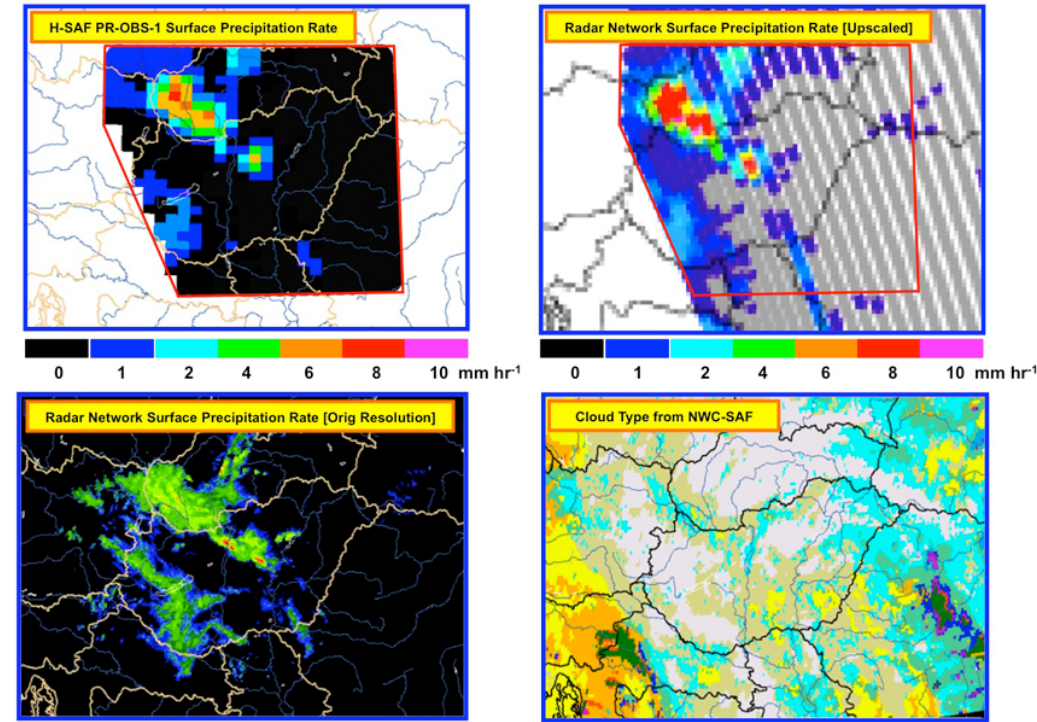
Fig. 10. Various sources of surface precipitation-rate products plus a cloud-type product over Hungary on 5 May 2010 at 16:29UTC: H- SAF’s PR-OBS-1 surface precipitation rate (upper left panel); corresponding Hungarian operational radar network surface precipitation rate in upscaled format (upper right panel); corresponding Hungarian operational weather radar network surface precipitation rate in original resolution format (lower left panel); and corresponding cloud type from NWC-SAF (lower right panel). Note upper panels use the same precipitation rate color bar ranging from 0 to 10mmh − 1 , whereas a different precipitation rate color bar is used for lower left panel (not shown). (Cloud type key also not